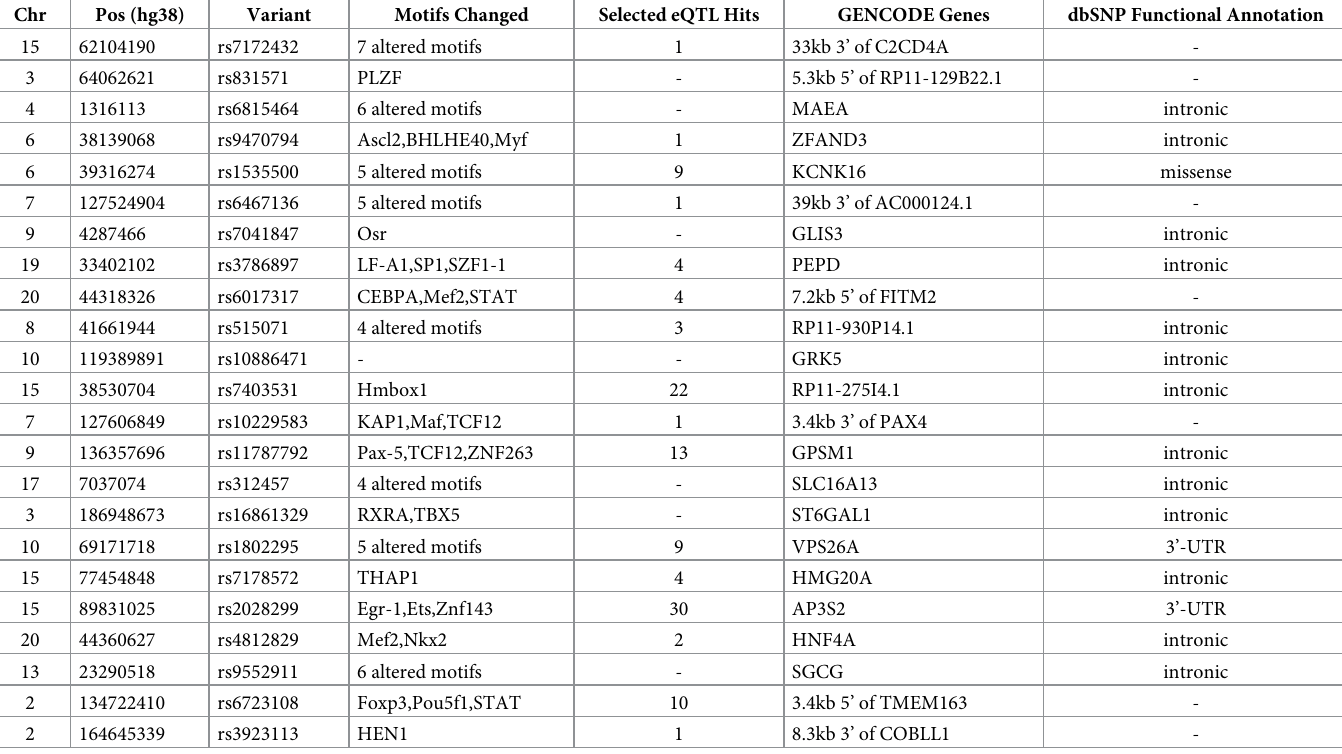
Table 1. Functional prediction of type 2 diabetes associated SNPs in Asian